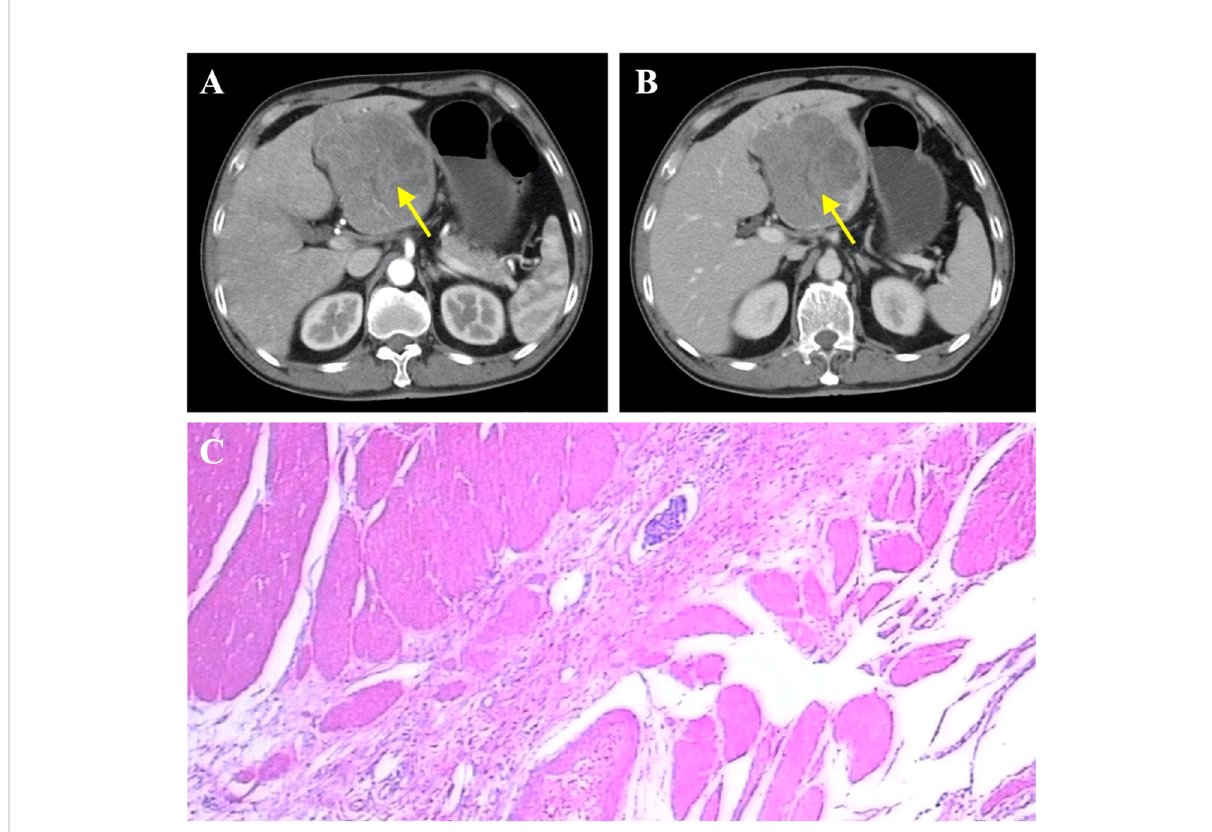
FIGURE 3 Diagnosis of primary liver cancer. (A) Liver cancer seen on contrast-enhanced CT (arterial phase), indicated by yellow arrow. (B) Liver cancer seen on contrast-enhanced CT (venous phase), indicated by arrow. (C) Representative histopathological image of liver